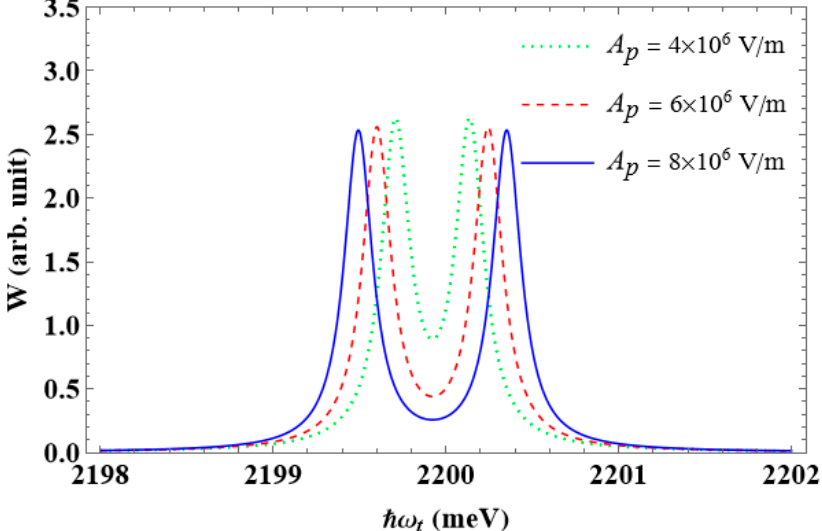
Figure 10. The dependence of the interband absorption spectra on the pump laser’s amplitude, A p , with R = 50 Å, θ 0 = 60 ◦ , and (cid:125) ∆ ω = 0 meV.